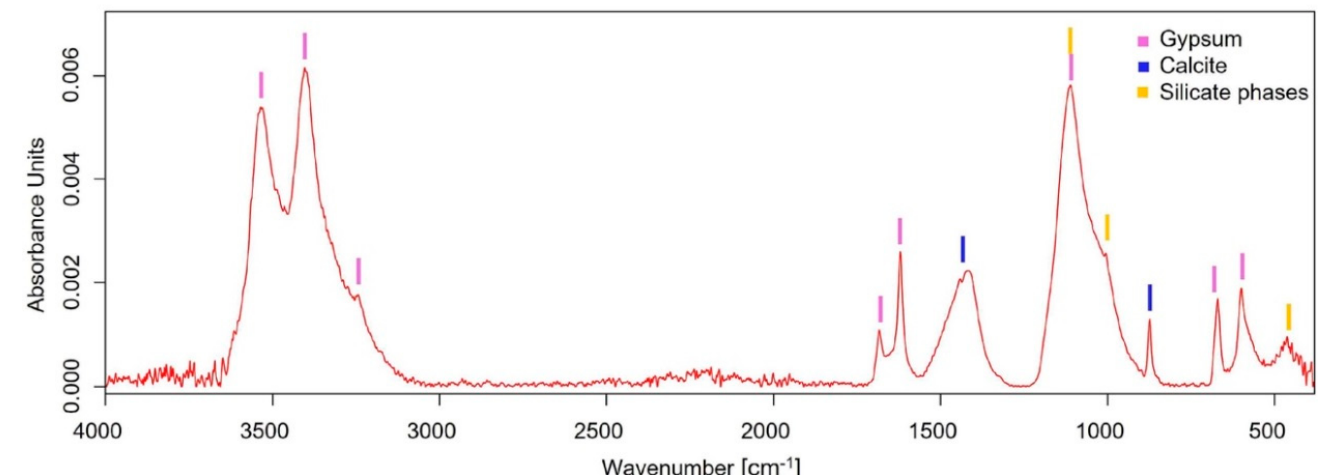
Figure 6. FTIR spectrum interpretation of P1 sample: bands of gypsum, calcite, and silicate phases are reported. Table 3. Results of the ATR–FTIR analysis of the preparatory samples. * represents weak peaks.